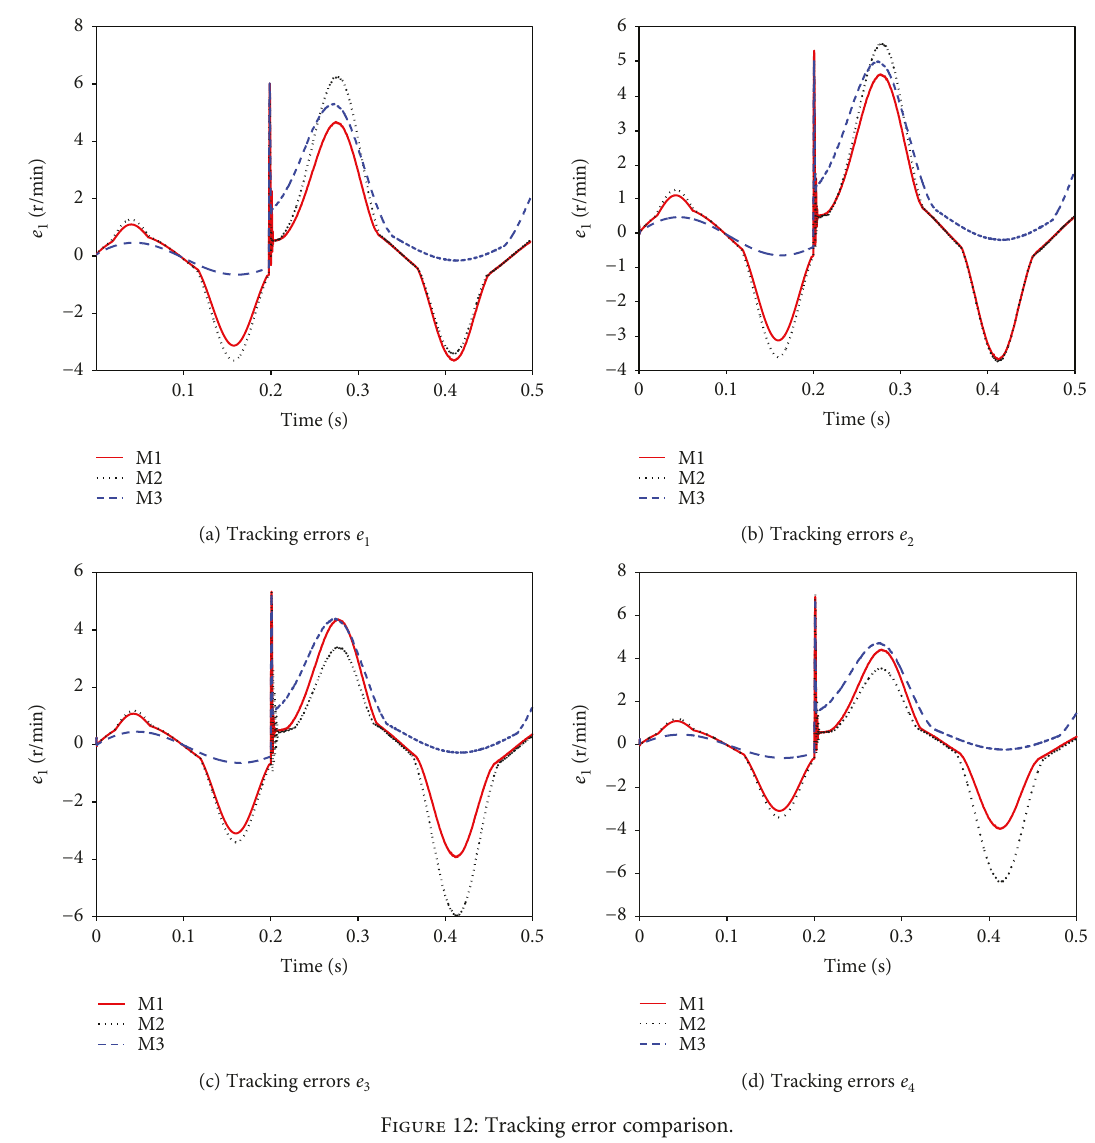
Figure 12: Tracking error comparison.